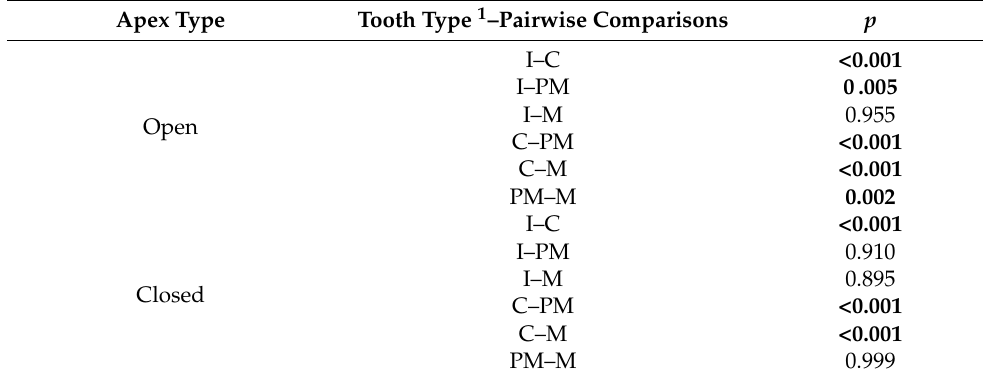
Table 3. Pairwise comparisons between permanent teeth by tooth type.